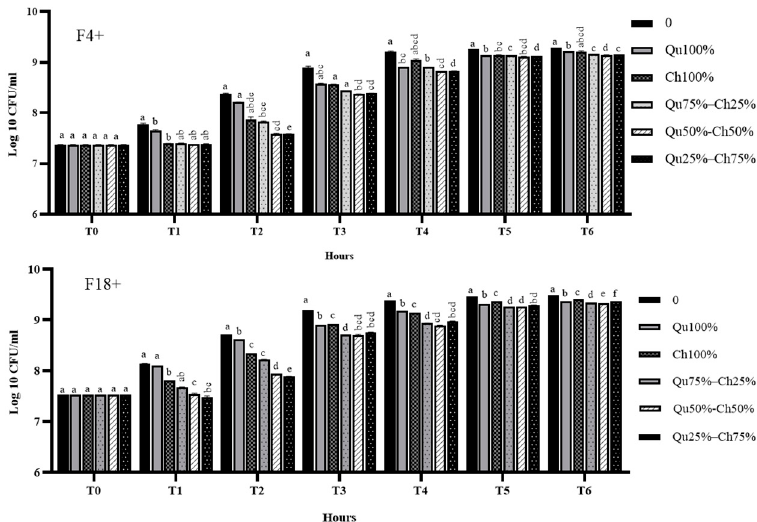
Figure 2. Effects of 1200 µg/mL of Qu (Qu100%), Ch (Ch100%), Qu75%–Ch25%, Qu50%–Ch50%, and Qu25%–Ch75% on E. coli F4+ and F18+ growth over time (T). Data are expressed as log10 CFU/mL lsmeans ± S.E.M. ( n = 3, mixed ANOVA). Different superscript letters indicate significant differences at p < 0.05 among different concentrations within the same time point.